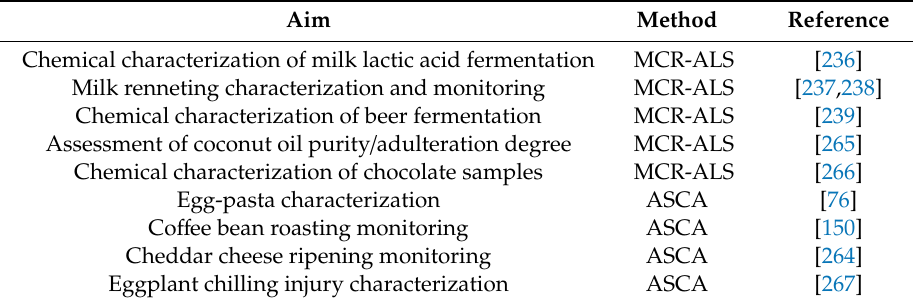
Table 4. Examples of applications of curve resolution and analysis of variance-based techniques in the fields of spectroscopy-based food analysis. MCR-ALS and ASCA stand for Multivariate Curve Resolution-Alternating Least Squares and ANOVA-Simultaneous Component Analysis,